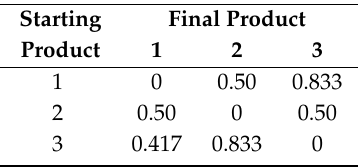
Table 5. Transition Times Between Products (h).